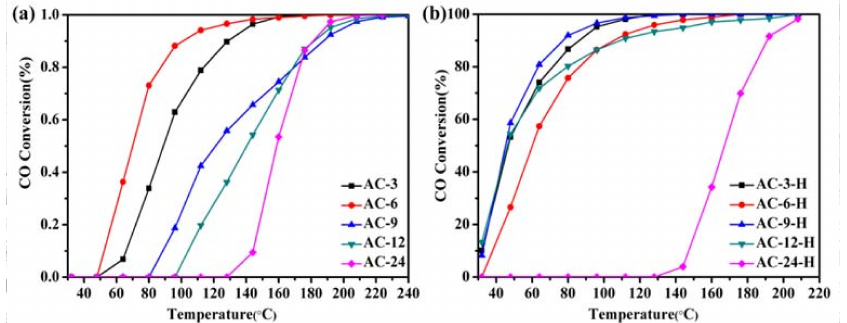
Figure 1. Catalytic performance in CO oxidation of Au-CeO 2 with or without H 2 pretreatments (( a ): unpretreated; ( b ): H 2 ).